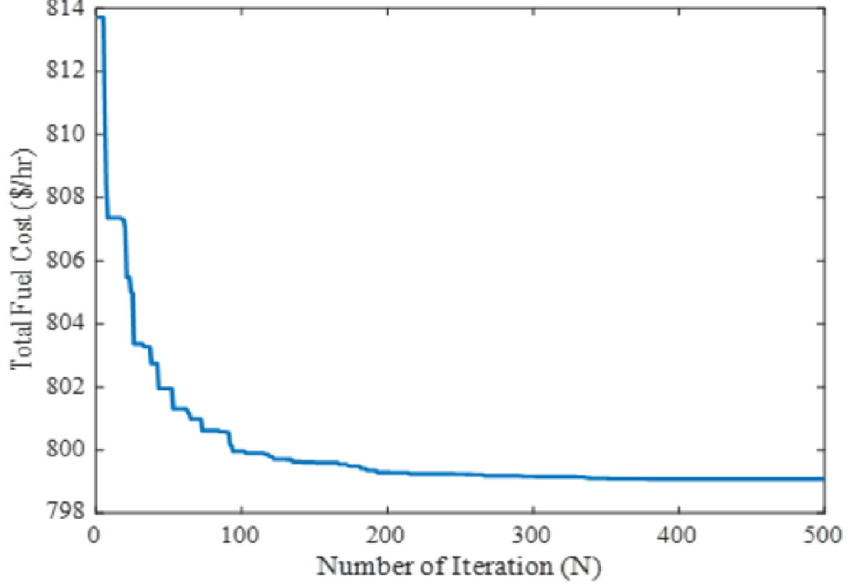
Fig 4. Convergence property of the proposed MPA for case